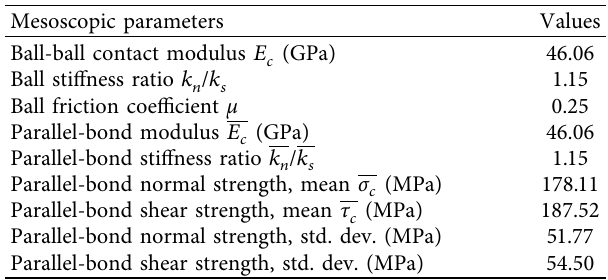
Figure 2: Sample size and loading directions of the PFC model. Table 1: Mesoscopic parameters of the PFC model.